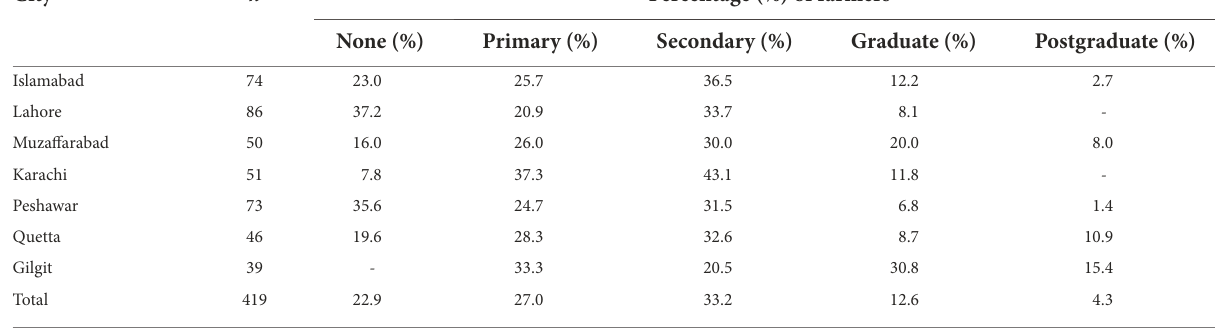
TABLE 1 Education of peri-urban dairy farmers in different Pakistani cities. City